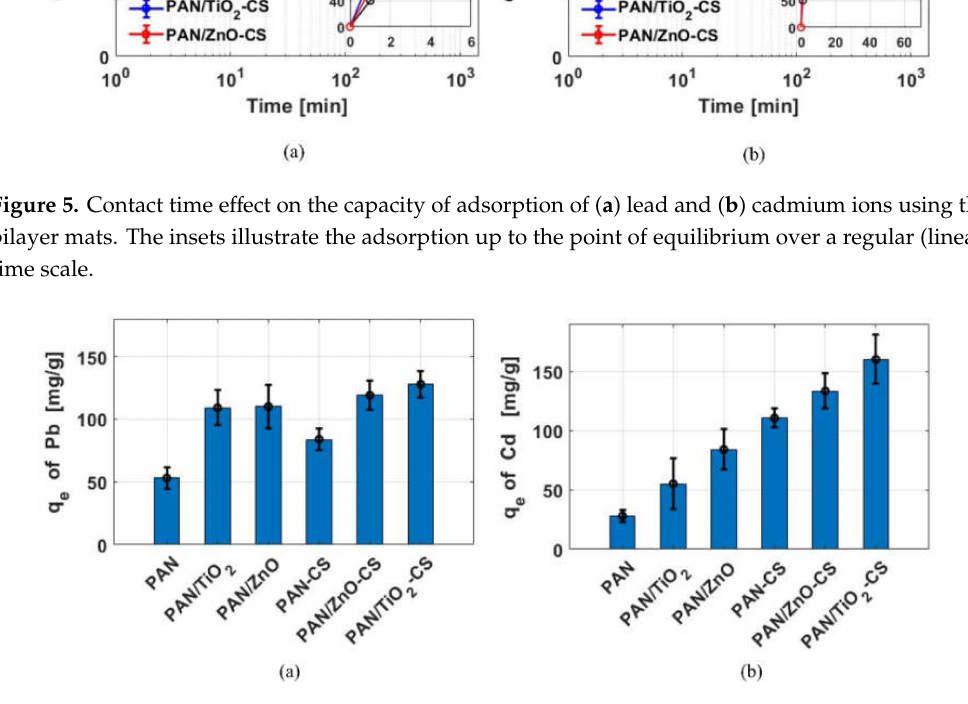
Figure 6. Equilibrium of adsorption (qe) comparison of ( a ) lead and ( b ) cadmium ions using pristine PAN, the PAN / MO single layer [9,25], the PAN–CS bilayer, and the PAN / MO–CS